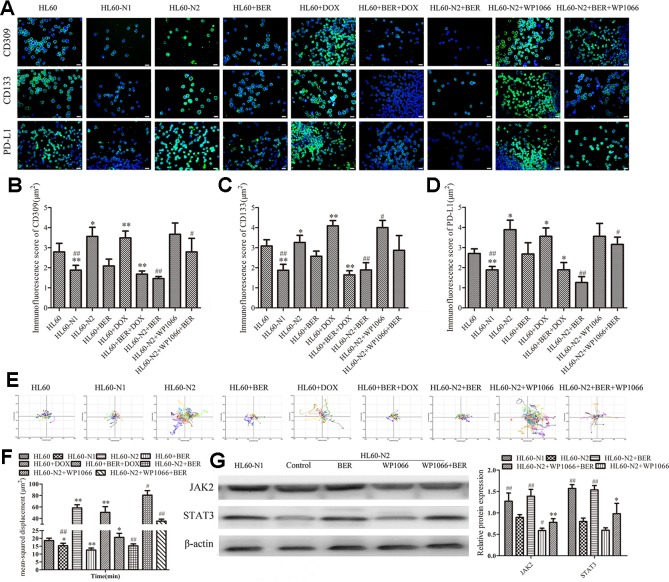
N1-like and N2-like neutrophils showed different phenotypic characteristics in stemness, mobility and jak2/stat3 signaling. (A) Cell protein expression of CD309, CD133, and PD-L1 indicated by immunofluorescence (n = 5, 40×). (B–D) Immunofluorescence score of (A) (n = 5). (E) Cell mobility observed by a laser holographic cell imaging and analysis system (n = 5, 20×). (F) The quantitative value of (E) (n = 5). (G) Protein expression levels of jak2/stat3 examined by Western blotting (n = 5). The data present mean ± SD, the experiments were repeated three times, and statistical significance was determined by a t-test. (B–D, F) *P < 0.05, **P < 0.01 vs. HL60; #P < 0.05, ##P < 0.01 vs. HL60-N2. (G) *P < 0.05, **P < 0.01 vs. HL60-N2+BER; #P < 0.05, ##P < 0.01 vs. HL60-N2. DOX, doxorubicin; BER, berberine.